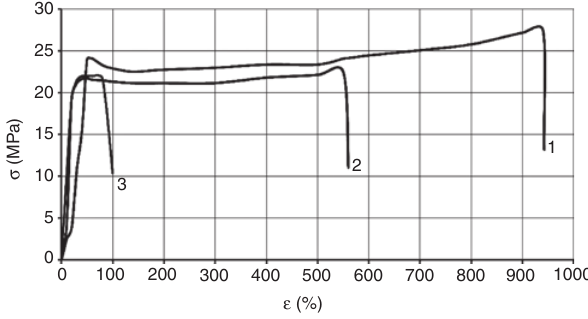
Figure 4: Tensile test curves for UHMWPE-based composites containing (1) 5, (2) 10 and (3) 20 wt% of carbon fillers.